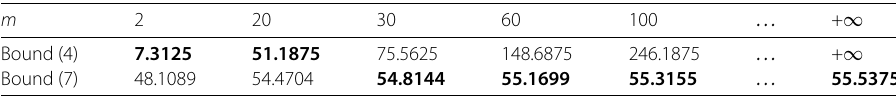
Table 1 Bound (4) and bound (7) for m = 2,20,30, ... ,+